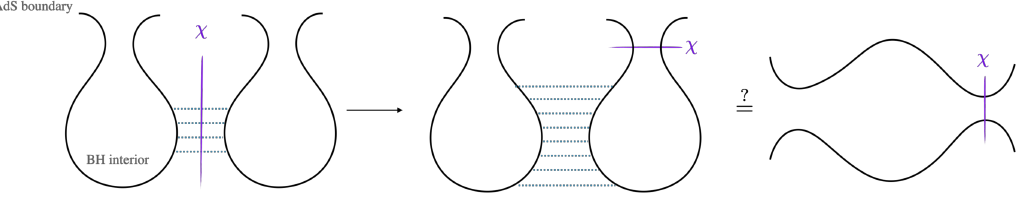
Figure 1. Schematic representation of the entanglement wedge transition in a model of two coupled black holes. The purple line is the HRT surface whose generalised entropy calculates the EE between the two boundary CFTs. At early times, each black hole interior is contained in the entanglement wedge of the corresponding boundary CFT. At late times, based on the island rule, we expect that the build-up of entanglement between the interiors causes one of the interiors to become part of the entanglement wedge of the other CFT. In this paper, we ask if this is the same as the entanglement lines condensing into a geometric